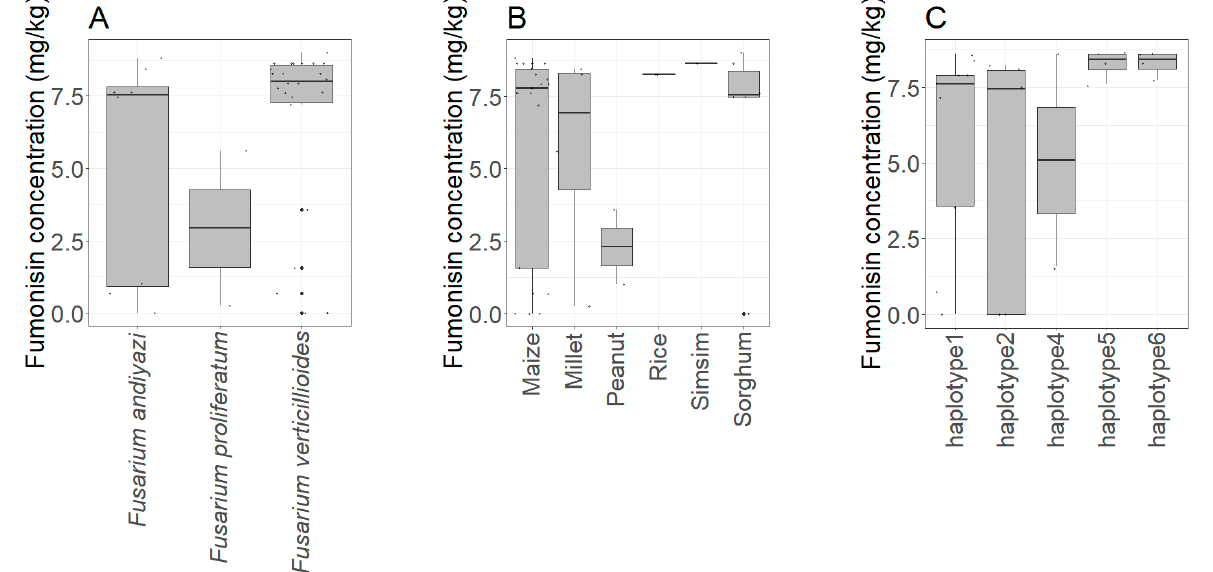
Figure 4. Fumonisins production among three species of Fusarium isolated from northern Uganda. ( A ) Variation in concentration of fumonisins among the species. ( B ) Variation in fumonisins production among isolates derived from different grain types. ( C ) Variation in fumonisins production in different haplotype groups of Fusarium verticillioides .